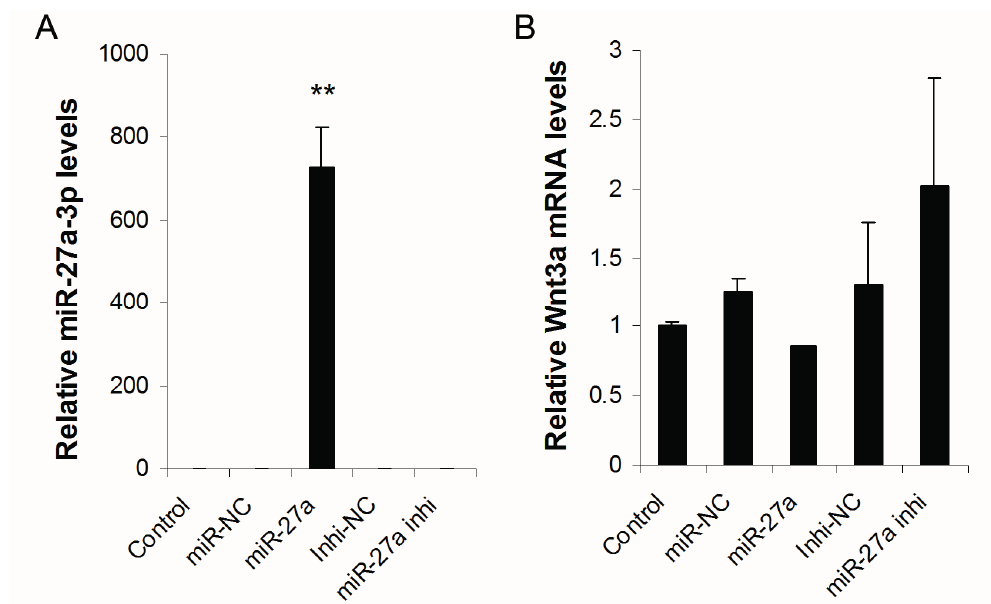
Figure 3. Expression levels of miR-27a-3p and Wnt3a mRNA in miR-NC, miR-27a, Inhi-NC, miR-27a inhi and Control group. ( A ) The miR-27a-3p expression level (728.6) is significantly higher in miR-27a group compared to other groups (Control: 1, Inhi-NC: 0.72, miR-27a inhi: 0.23, miR-NC: 1.92) ( p < 0.01). The expression levels of miR-27a-3p in miR-27a inhi groups are significantly less than other groups ( p < 0.05); ( B ) There are no significant difference in Wnt3a mRNA expression levels between control and other groups. Values represent the mean ± SE from four independent experiments. ** p <